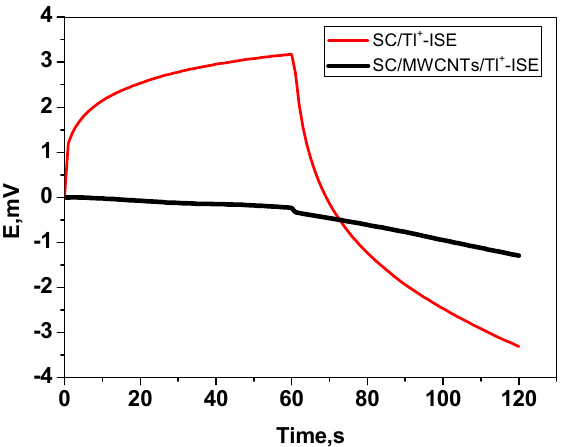
Figure 6. Chronopotentiograms for the solid-contact(SC / Tl + -ISE) (top) and SC / MWCNTs / Tl + -ISE (bottom) electrodes under the constant currents of ± 1 nA in 1.5 × 10 − 5 M of Tl + solution.